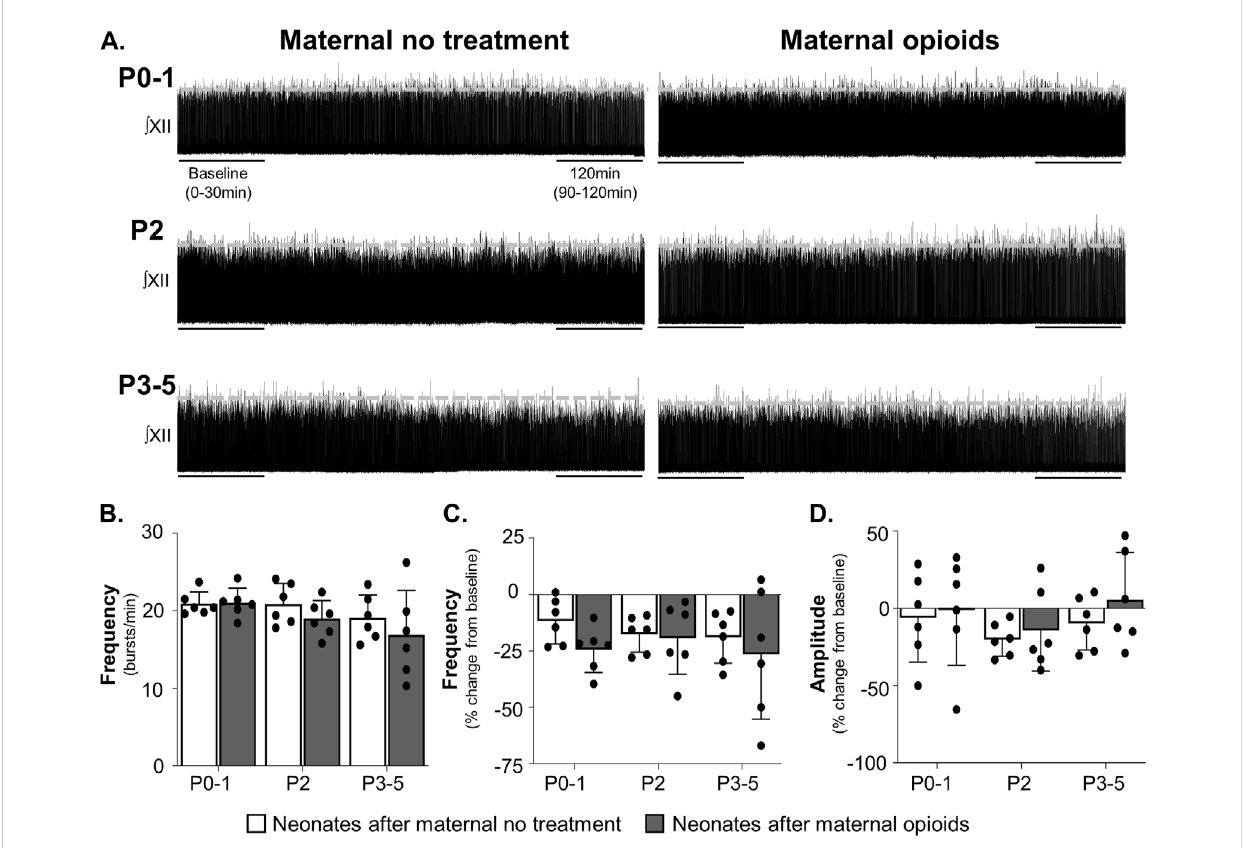
FIGURE 6 Isolated respiratory network activity was maintained in rhythmically active slices containing the preBötzinger Complex in neonates after maternal opioids. Representative neurograms (A) show respiratory activity from isolated rhythmic slices was maintained in neonates after maternal opioids at all ages. Baseline neonatal burst frequencies (B) were similar in neonates, regardless of maternal treatment or age. Over time, isolated rhythmic slice burst frequencies (C) and amplitudes (D) were unchanged from baseline and similar between maternal treatments and ages (Three-way ANOVA; Bonferroni post-hoc